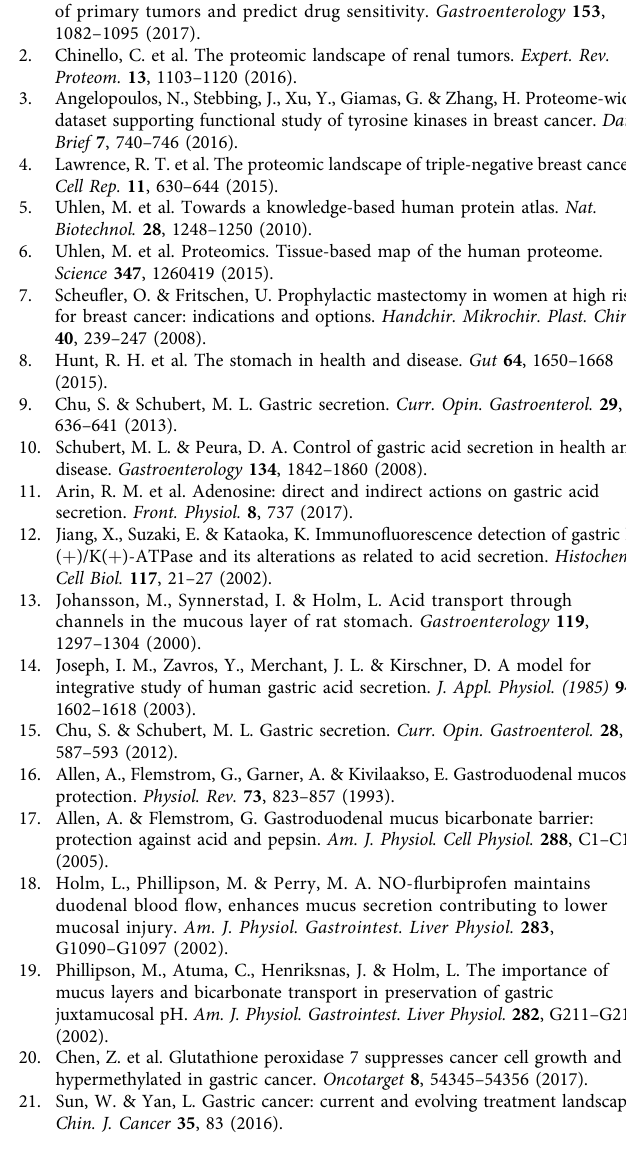
algorithm (number of iterations = 500; Distance measured: 1-Pearson correlation; proportion of items to sample: 90%). Proteins used for subtyping should be detected in at least 20% of GCA patients ( n = 12) and 75% of them were called as outliers in either the tumor or nearby tissues. With these criteria, outlier proteins